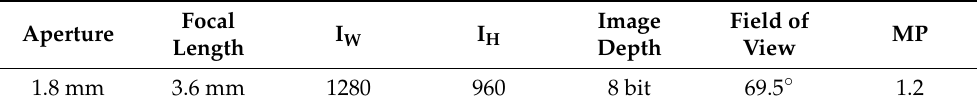
Table 2. Camera and image characteristics of the multiSPEC 4c. Aperture